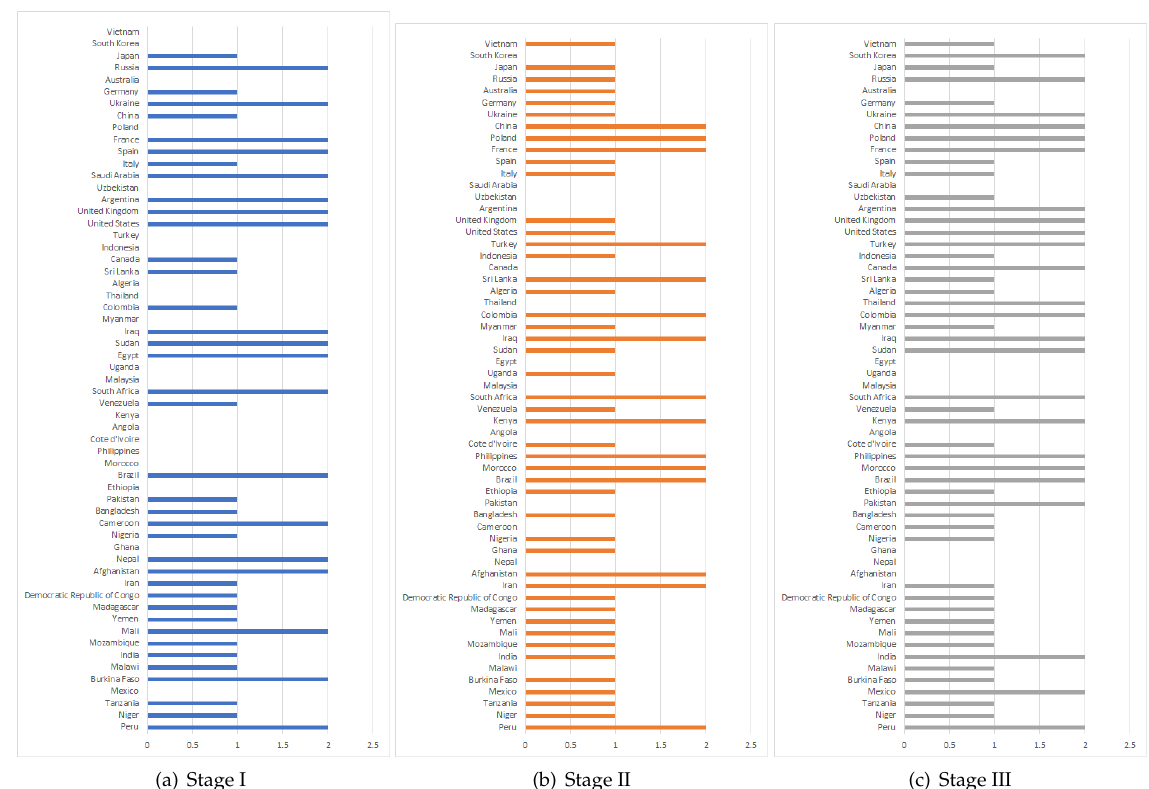
Figure A2. Potential scores of part of